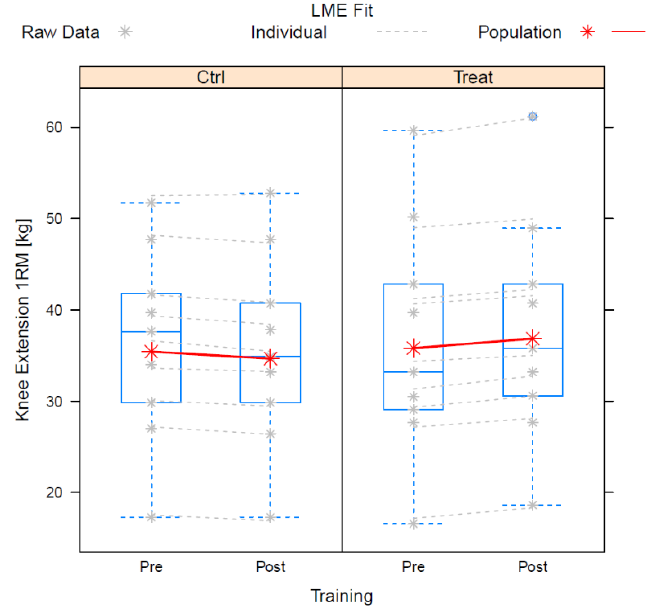
Figure 2. Boxplots of the raw data of the individual fits and of the population fits for knee extensor.